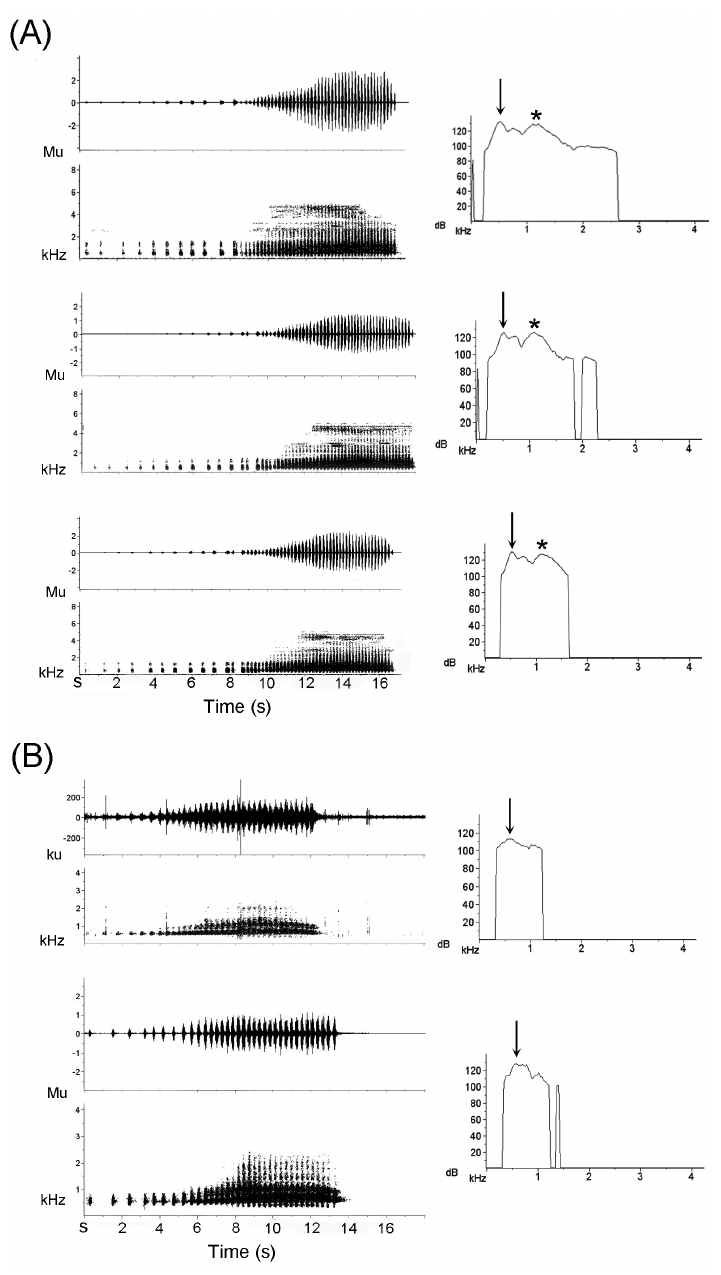
Figure 6. Oscillogram, sound spectrogram (first column), and power spectrum (second column) of ad- vertisement calls of Tepuihyla shushupe sp. n. ( A ) and Tepuihyla tuberculosa comb. n. ( B ). Note differences in call length and number of notes (first column). Both species have the dominant frequency (arrows) in the first harmonic but in Tepuihyla shushupe sp. n. the second harmonic has similar energy content (asterisk), while in Tepuihyla tuberculosa comb. n. it has much